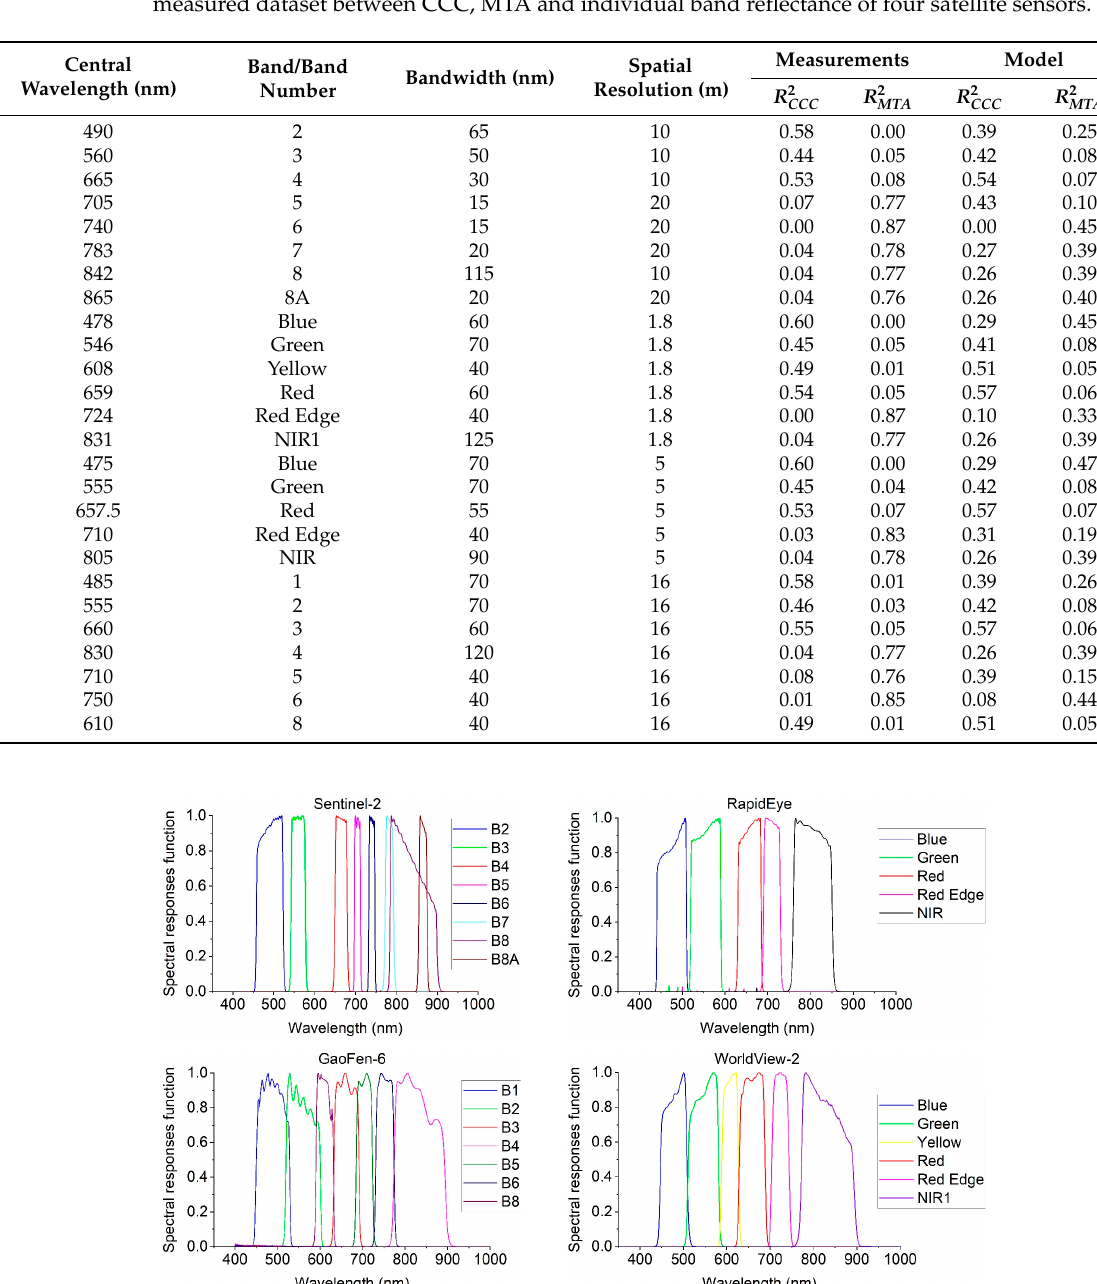
Table A1. The central wavelength, bandwidth and spatial resolution and R 2 values from field measured dataset between CCC, MTA and individual band reflectance of four satellite sensors.